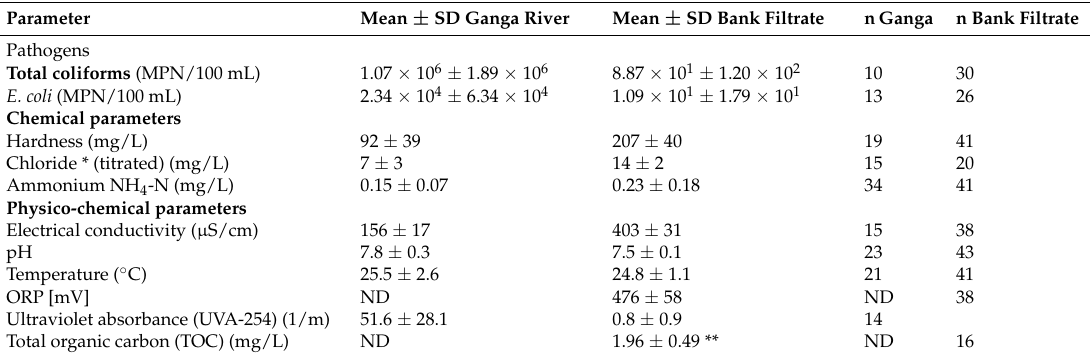
Table 4. Water quality of the Ganga River water and bank filtrate.